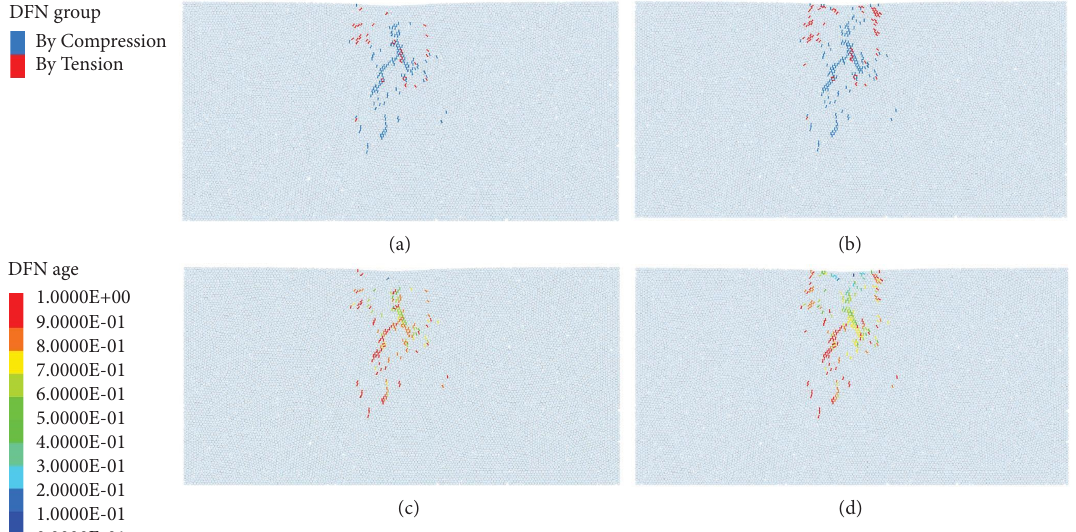
Figure 8: Distribution of the discrete fracture network with time: (a) DFN-type distribution under a single disc cutter, (b) DFN-type distribution assisted by ultrasonic vibration, blue lines represent tensile cracks caused by compression and red lines by tension, (c) DFN changes with time under a single disc cutter, and (d) DFN changes with time assisted by ultrasonic vibration.